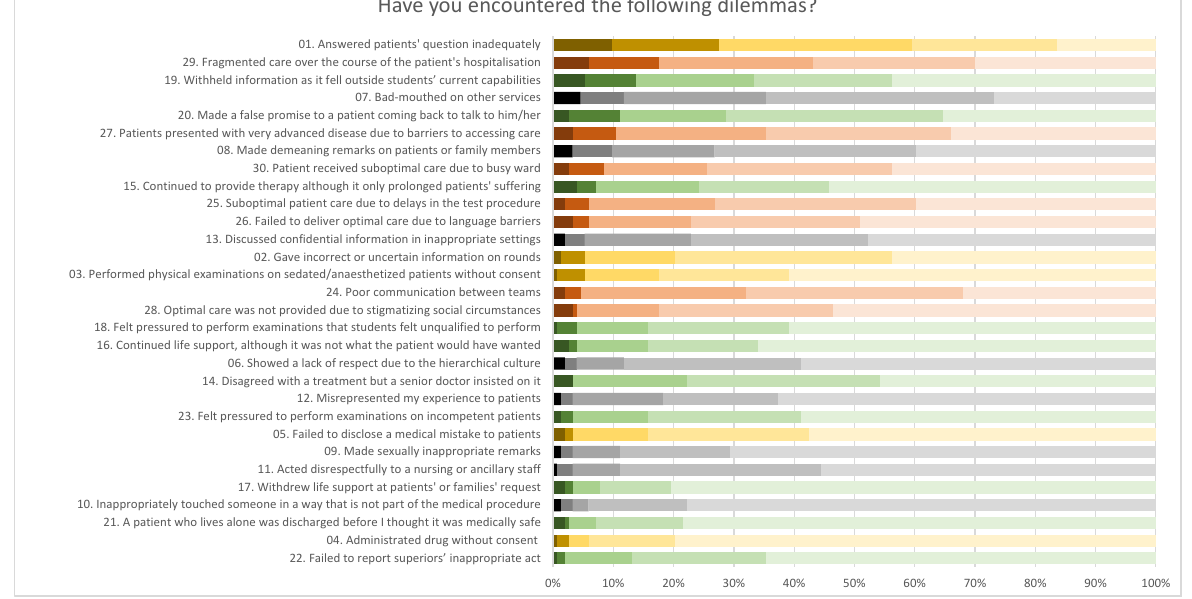
Figure 1. Frequency of professionalism dilemmas encountered by medical students. (1) Bar color indicates the theme of the measures: yellow = involvement in care perceived to be substandard; gray = professionalism lapses; green = responsibility exceeding students’ capabilities; orange = system constraints. (2) Dark and light color palette (From left to right): very frequently, frequently, occasionally, infrequently, and never.